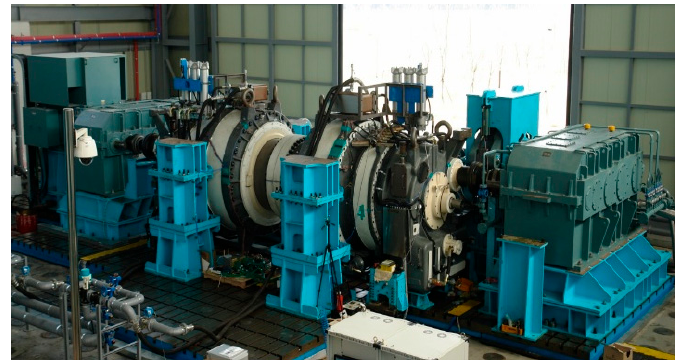
Figure A2. Picture of the developed test rig. Table A1. List and description of test rig components.